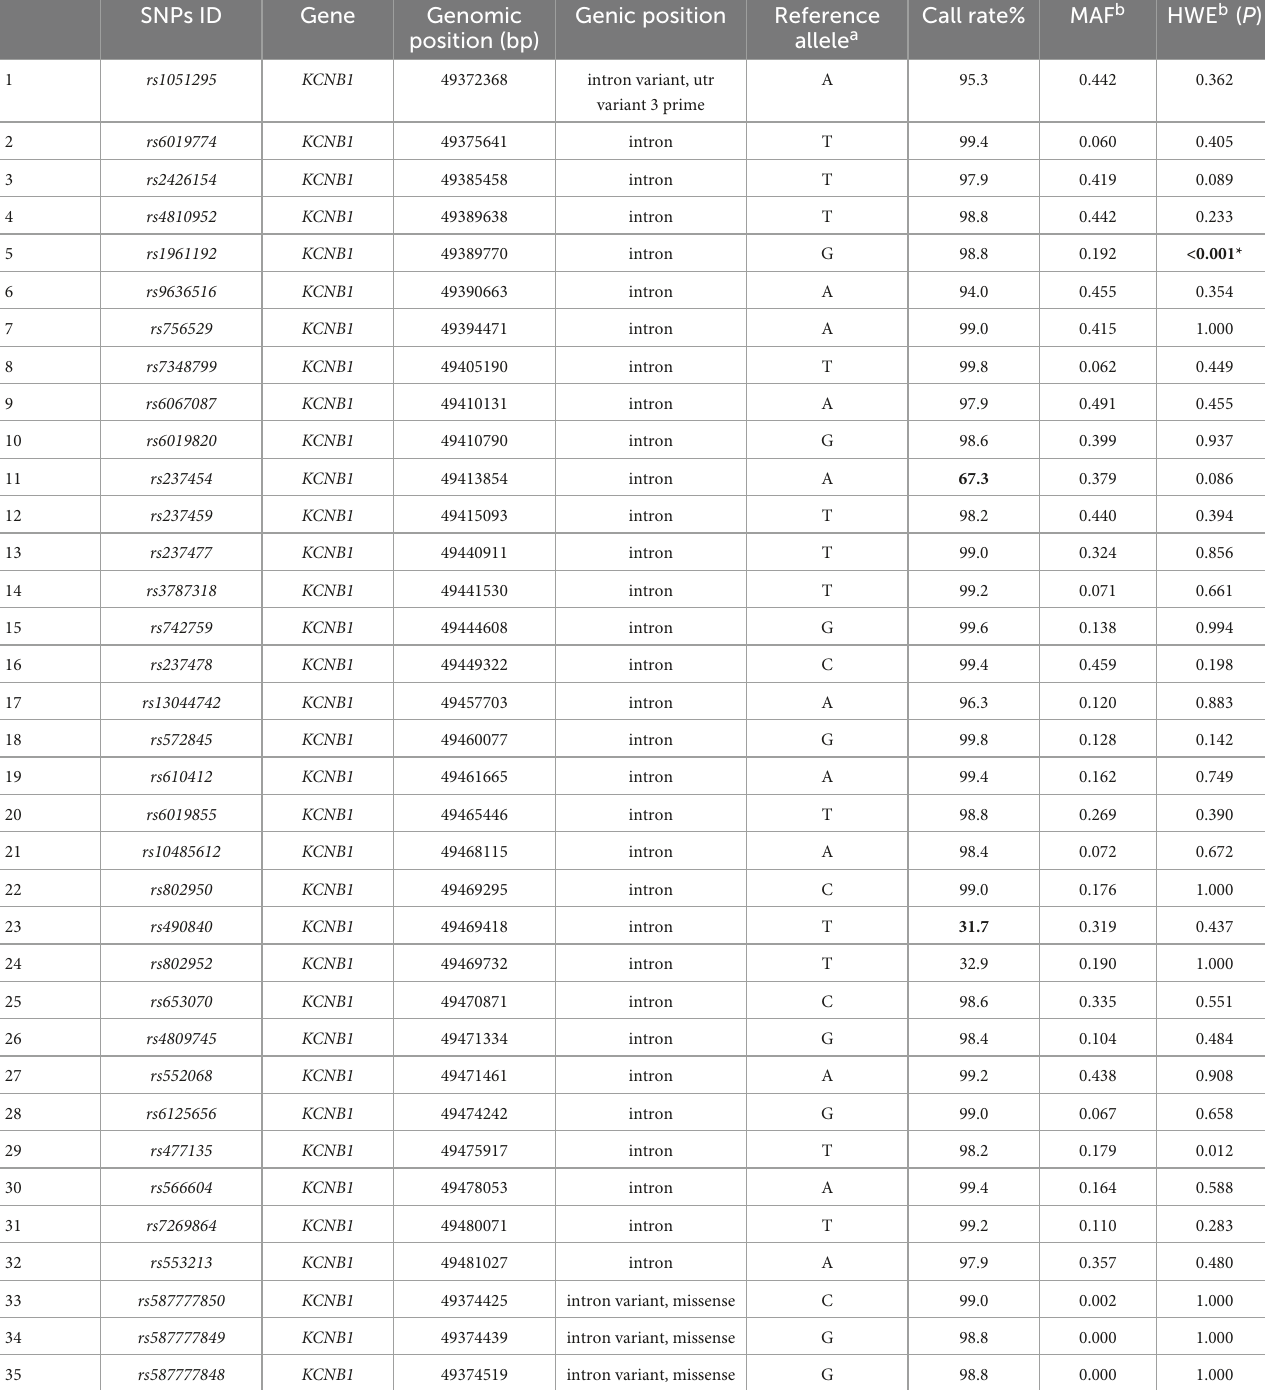
TABLE 1 Characteristics of KCNB1 single nucleotide polymorphisms (SNPs).